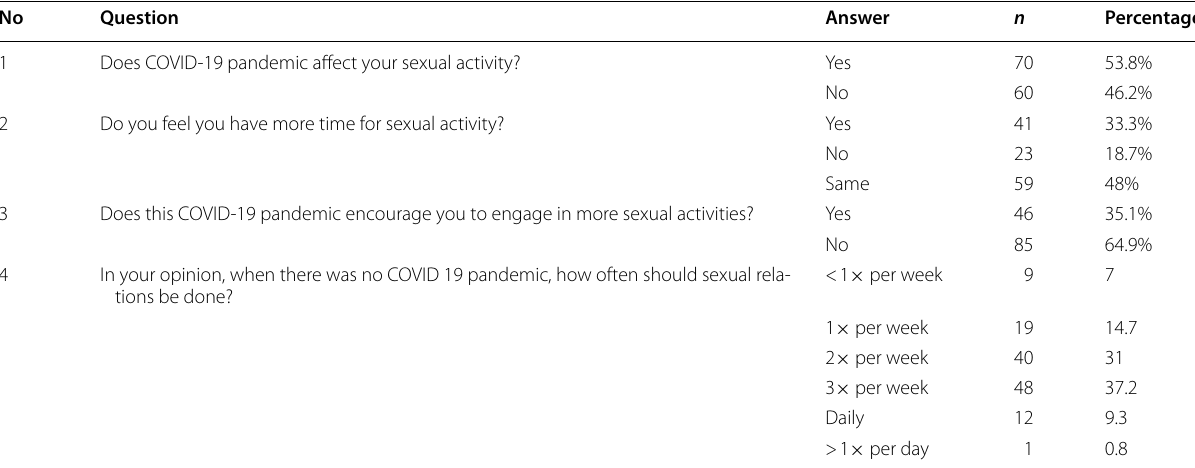
Table 3 Subjects’ responses about sexual activities changes